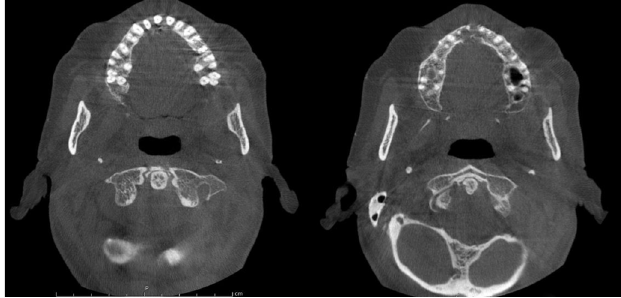
Fig. 2. Computer tomographic views in axial section showing the